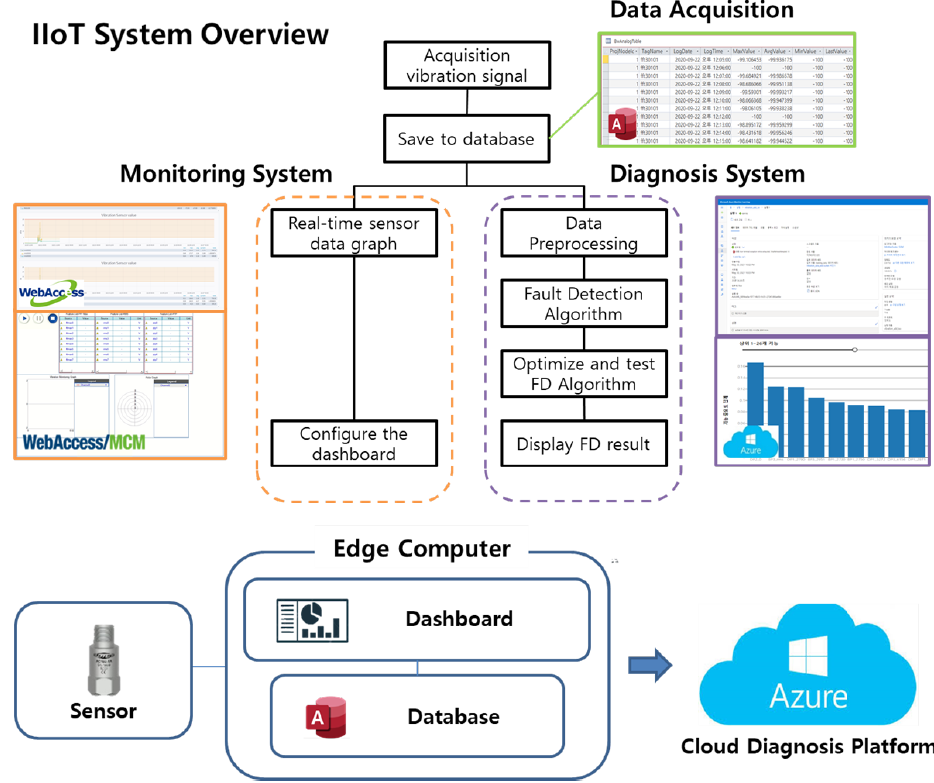
Figure 2. Edge monitoring system and cloud diagnostic system.